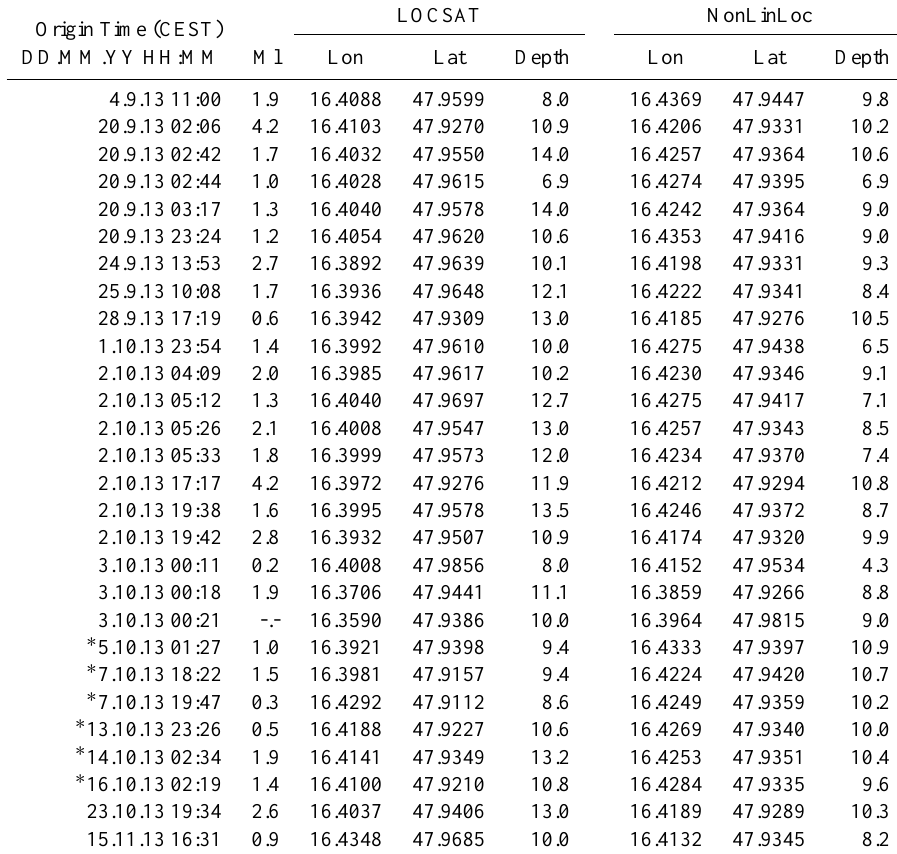
Table 1. Hypocentral parameters with LOCSAT and NonLinLoc, events located with LOCSAT using VB01, VB02 and VB03 are marked with ∗ at the beginning of the